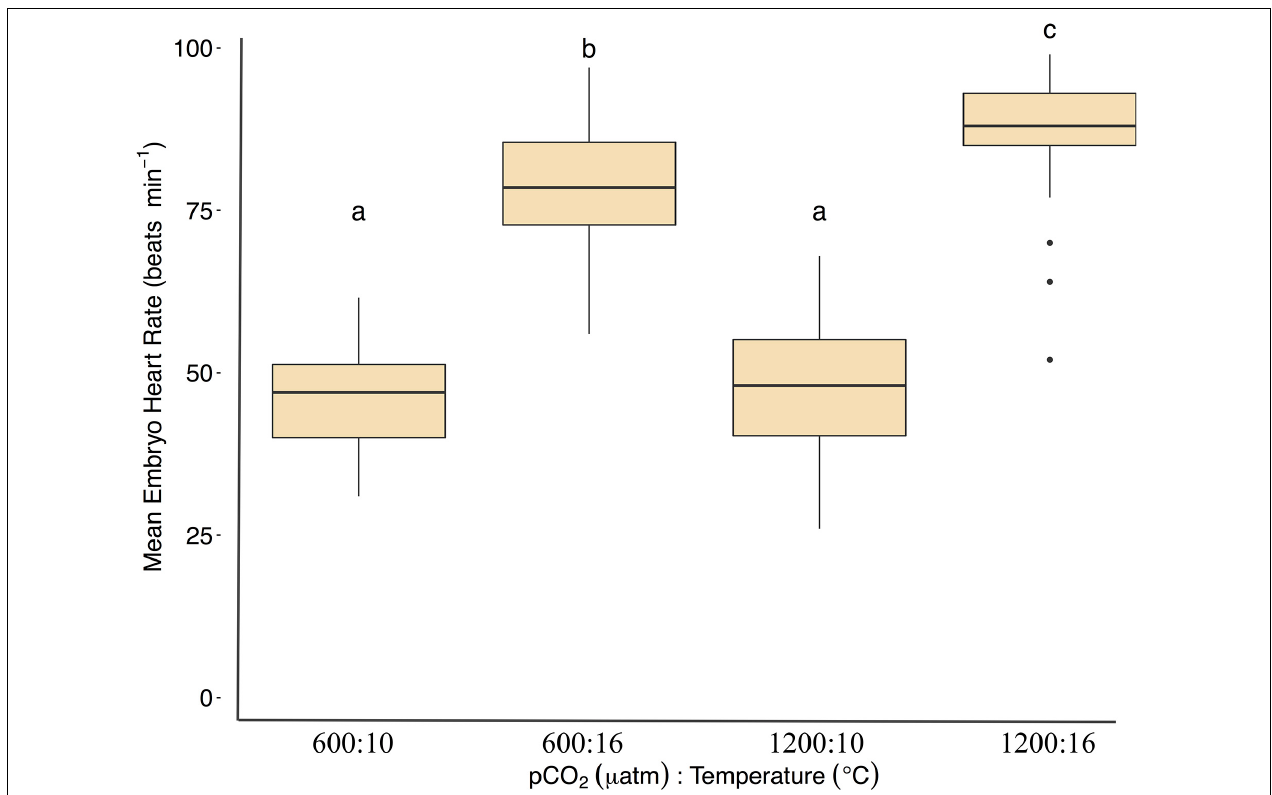
FIGURE 4 | Treatment effects of Pacific herring embryo heart rates (beats min − 1 ). Heartbeats were recorded during 1-min intervals on either day 4 (16 ◦ C) or day 5 and 6 (10 ◦ C). Data are based on the mean ± 1 SD of (n) measurements 600 µ atm:10 ◦ C ( n = 72), 1200 µ atm:10 ◦ C ( n = 71), 600 µ atm:16 ◦ C ( n = 32), and 1200 µ atm:16 ◦ C ( n = 30). Lower-case letters indicate statistically different treatments based on a Tukey’s HSD post hoc